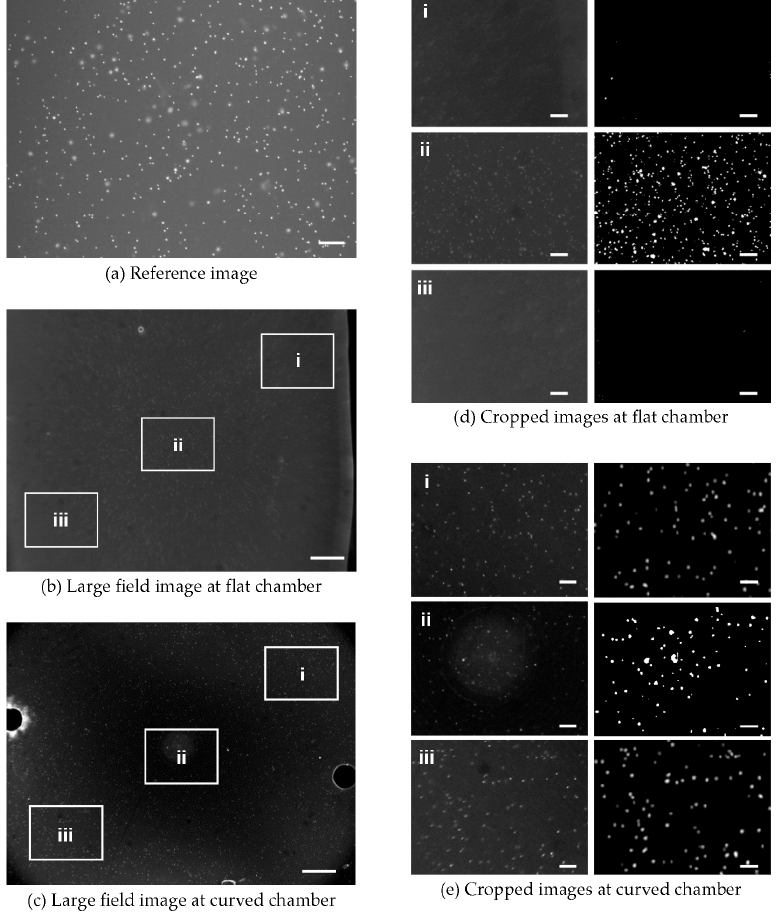
Figure 8. Fluorescence images of stained white blood cells in small and large field imaging. ( a ) Microscopic image of flat chamber. The inset white boxes in ( b , c ) are of the same size in the microscopy images of the flat and curved chambers. ( d , e ) Cropped areas of the flat and curved chamber images, where (ii) denotes the center part of an image. All cropped images are of the same size. The cell counts in the center (ii) were similar for both chambers. The bars in ( b , c ) represent a scale of 1 mm, while those in the other figures represent a scale of 200 µm.